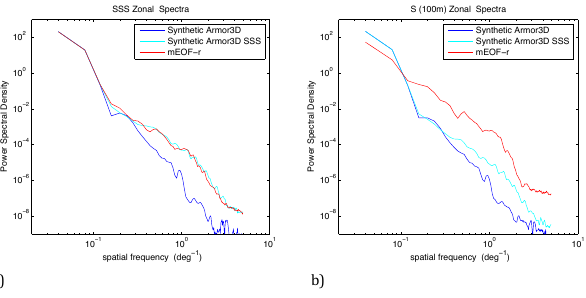
Fig. 10. Zonal wavenumber spectra computed from the recon- structed salinity fields at the surface (a) and at 100m depth (b) .